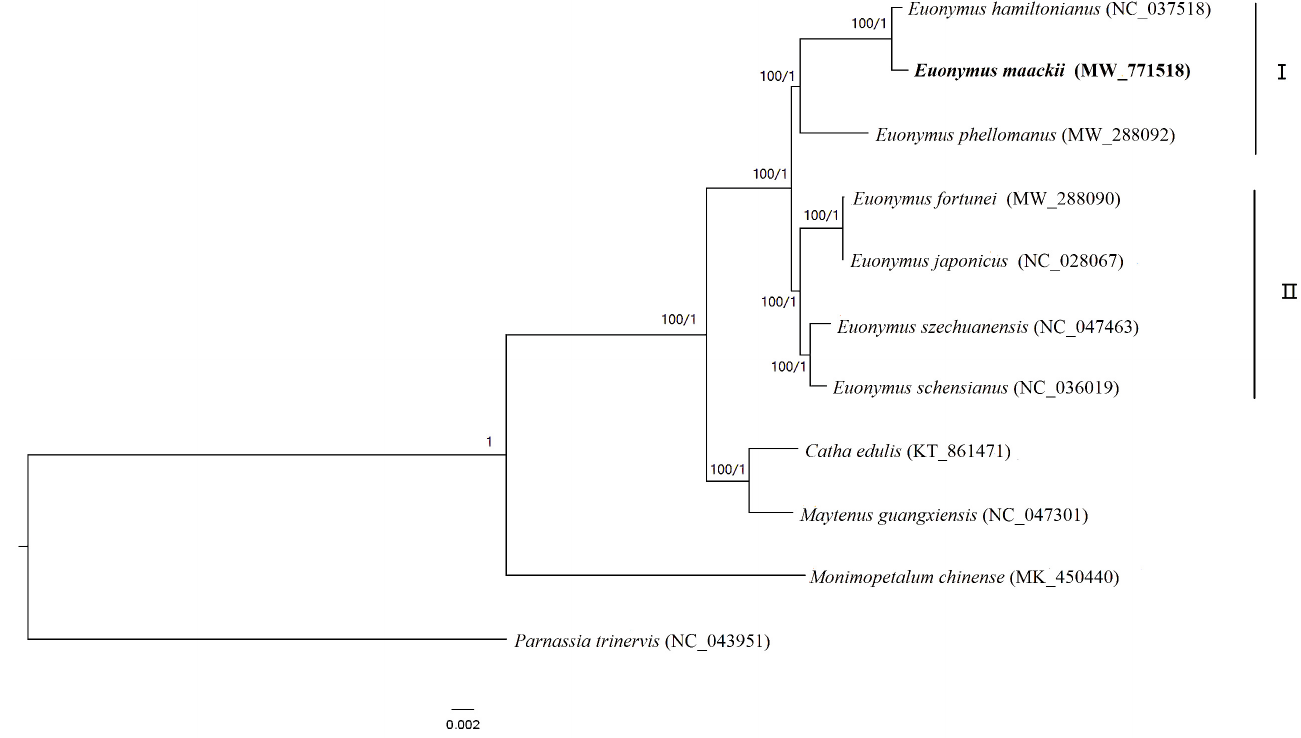
Figure 6. Phylogenetic tree based on the whole plastome. The numbers to the left of the slashes on the branches show the bootstrap values obtained by maximum likelihood analysis, and those on the right show the posterior probabilities according to Bayesian